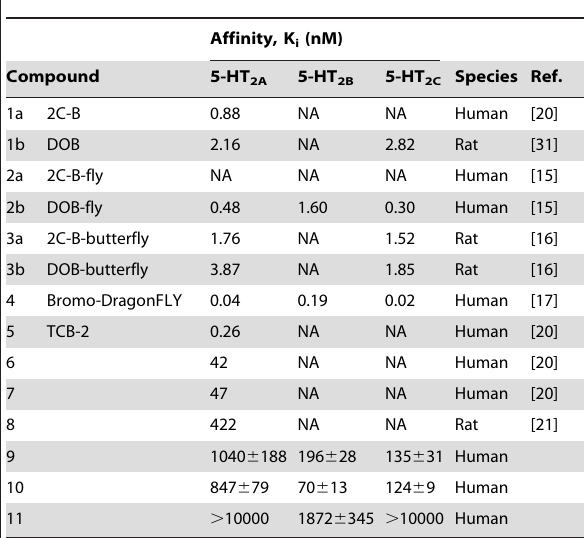
Table 1. Binding affinities of published ( 1 2 8 ) and new ( 9 2 11 ) compounds at human 5-HT 2